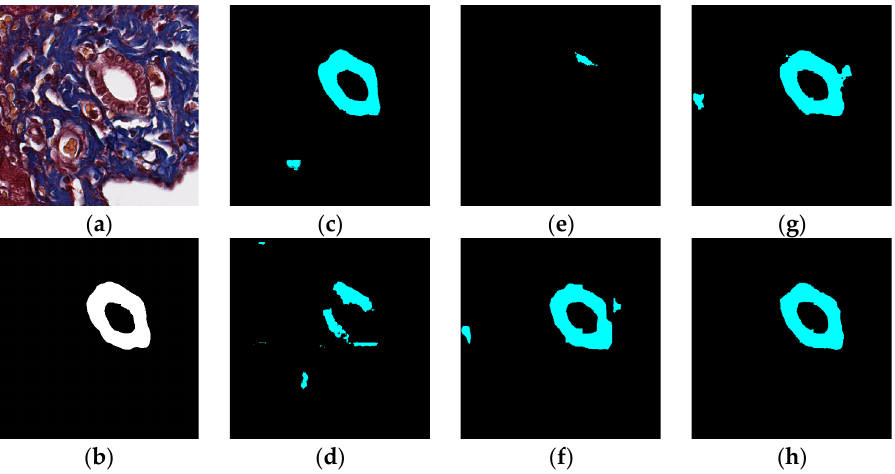
Figure 7. Segmentation results for clearly visible bile ducts: original ( a ), GT ( b ), FCN ( c ), SegNet ( d ), U ‐ Net ( e ), Deeplabv3 ( f ), Deeplabv3 ‐ plus ( g ), and the proposed network ( h ).